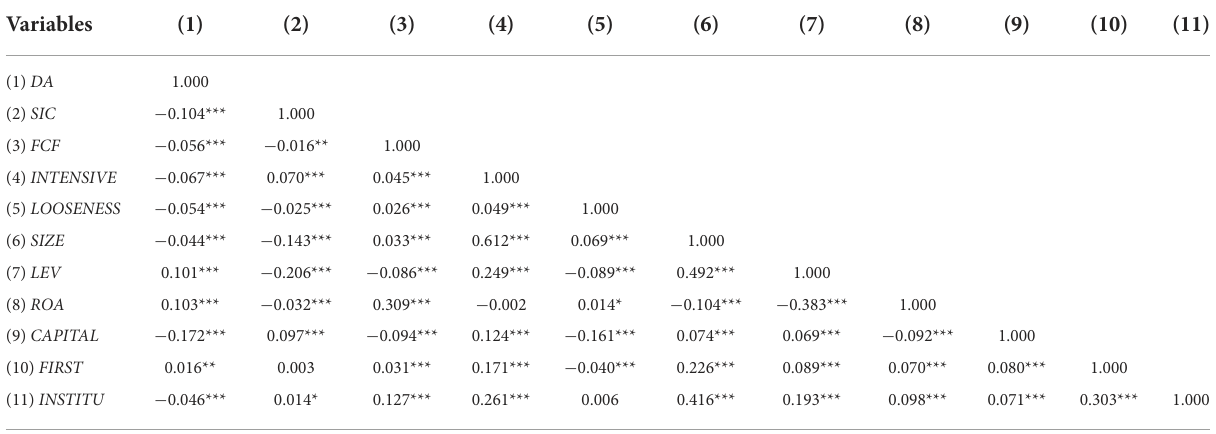
TABLE 2B Correlation